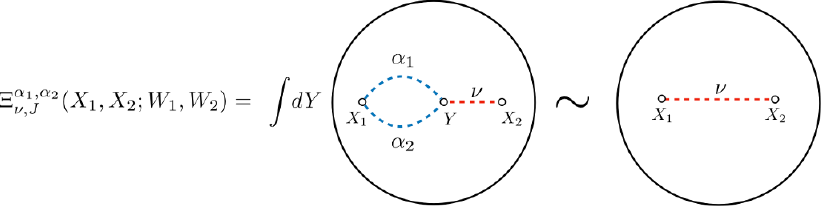
( X 1 ; X 2 ; W 1 ; W 2 ). According to the complete- (cid:23);J